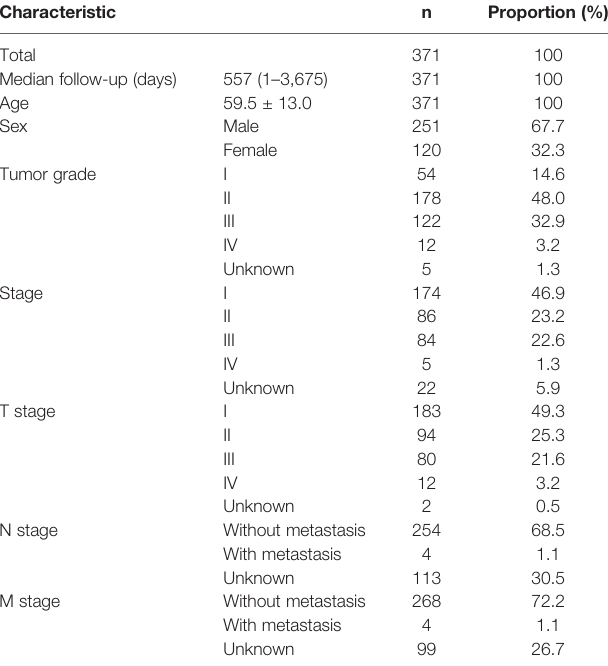
TABLE 2 | Baseline data of all HCC